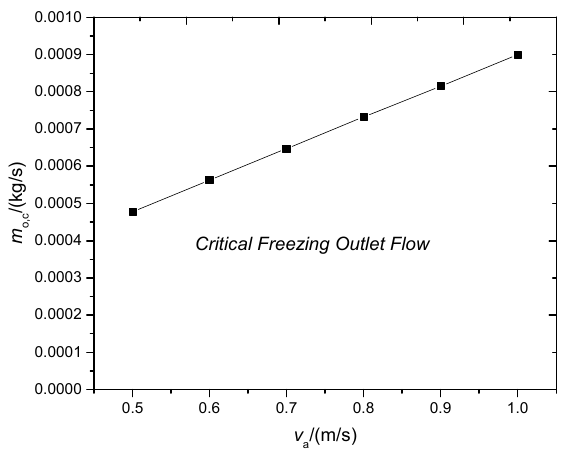
Figure 11. Critical freezing outlet flow versus windward velocity.